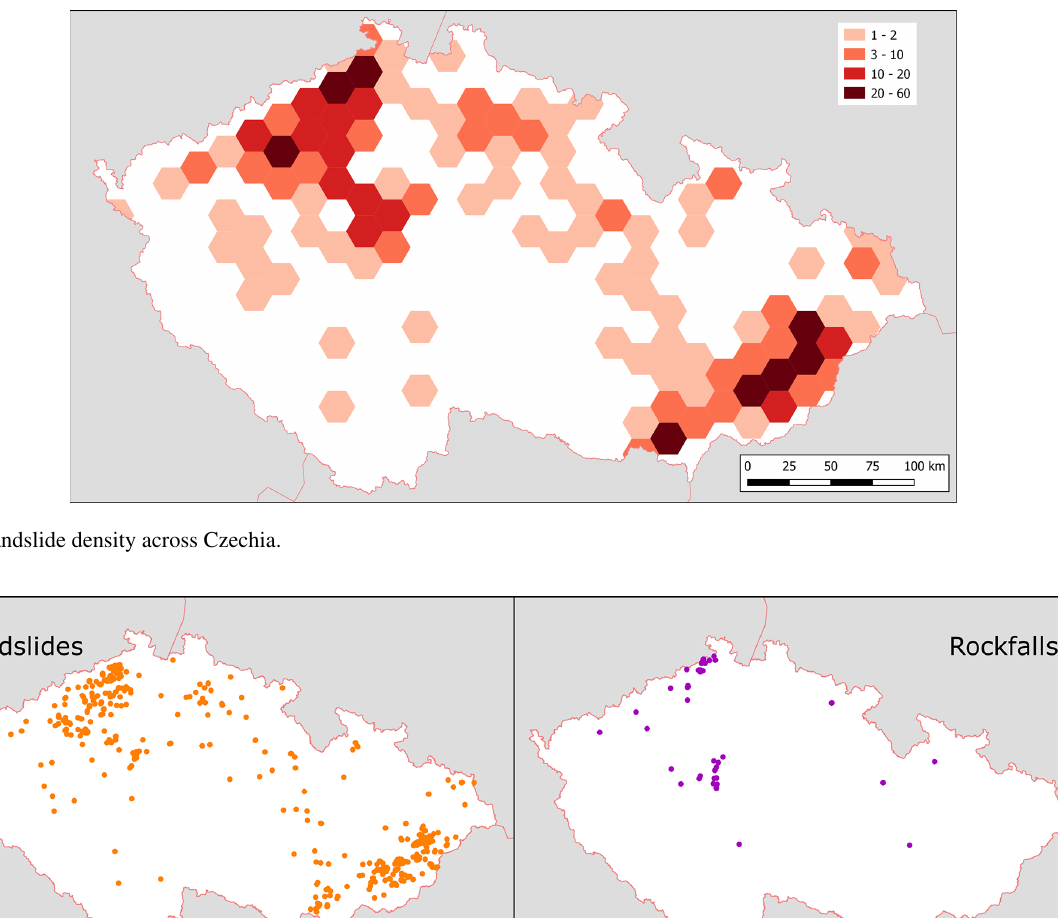
Czechia (DV area) and along the Vltava/Moldau river valley (VR) south of Prague (Fig.